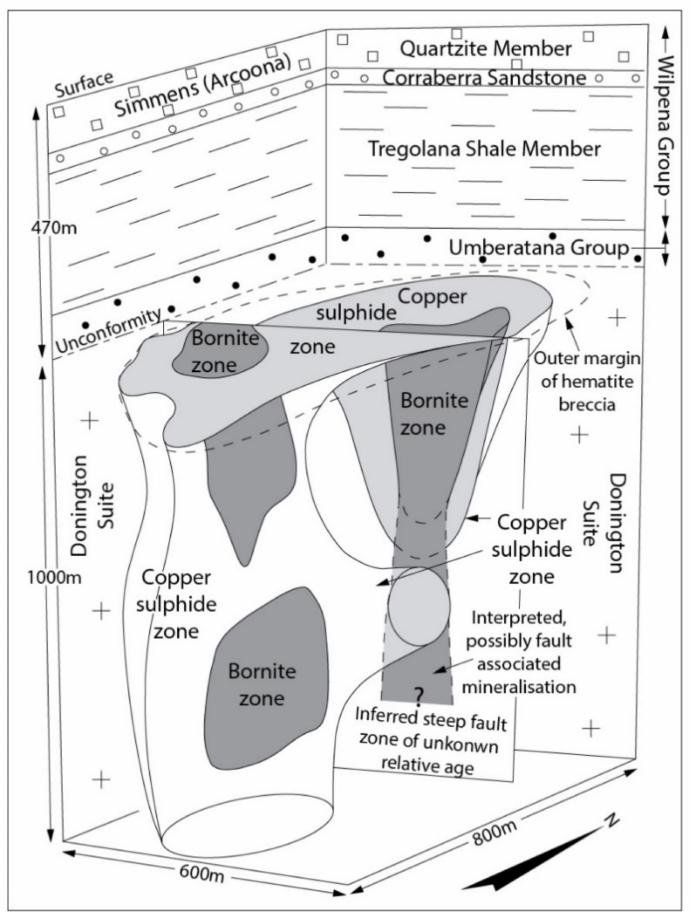
Figure 2. Schematic section of the Carrapateena IOCG deposit and overlying cover sequence materials of the Umberatana Group and Wilpena Group. After